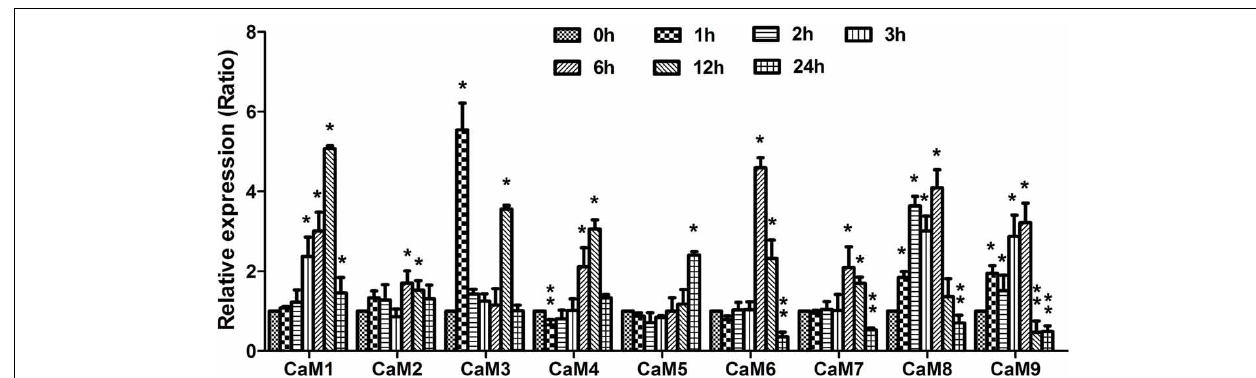
FIGURE 5 | Effects of 3OC6-HSL on the expression of CaM genes in Arabidopsis roots. The plants were grown in hydroponic Hoagland medium with or without 1 μ M 3OC6-HSL. Total RNA was extracted from roots at different time interval after 3OC6-HSL treatment and analyzed by quantitative RT-PCR with specific primers for individual AtCaM gene. Values were